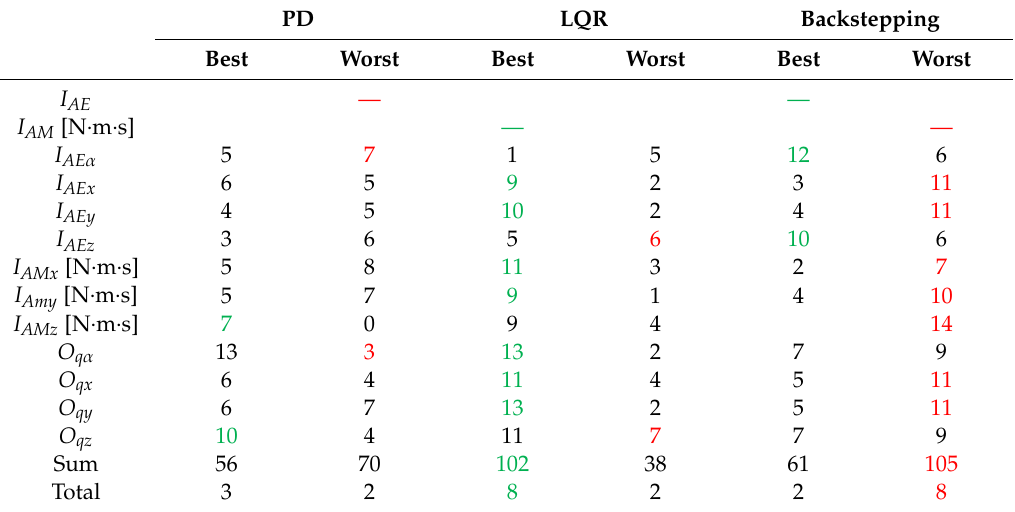
Table 4. Overview of quality indicators of controllers’ ( I AE —the integral of absolute error, I AM —the integral of absolute desired torque, O q —the maximum absolute variation of the quaternion). PD LQR Best Best